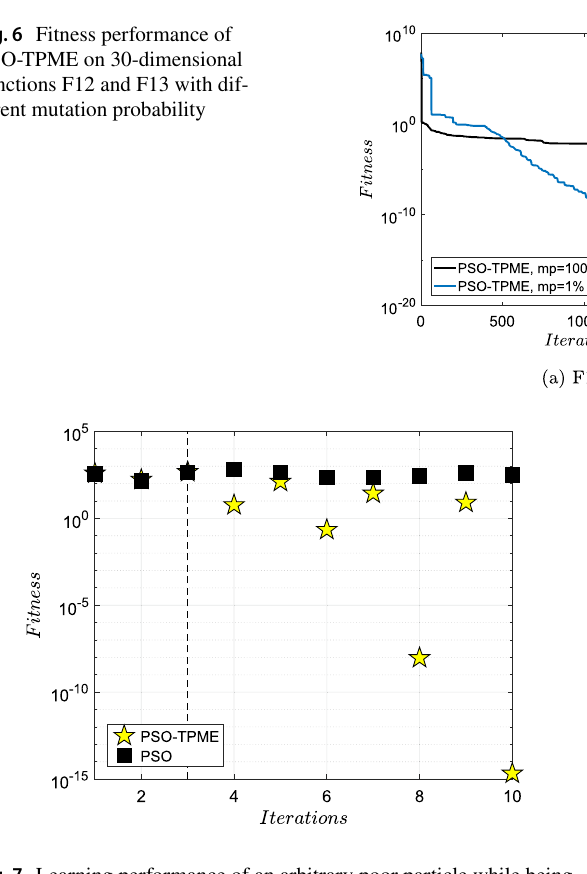
Fig. 7 Learning performance of an arbitrary poor particle while being handled by PSO-TPME and PSO w/o elitism-mutation on 30-dimen- sional Griewank function (F11) for the first 10 iterations Fig. 8 Fitness performance of PSO variants on 30, 60 and 90 dimensional Griewank function (F11) after 10 and 2000 itera-